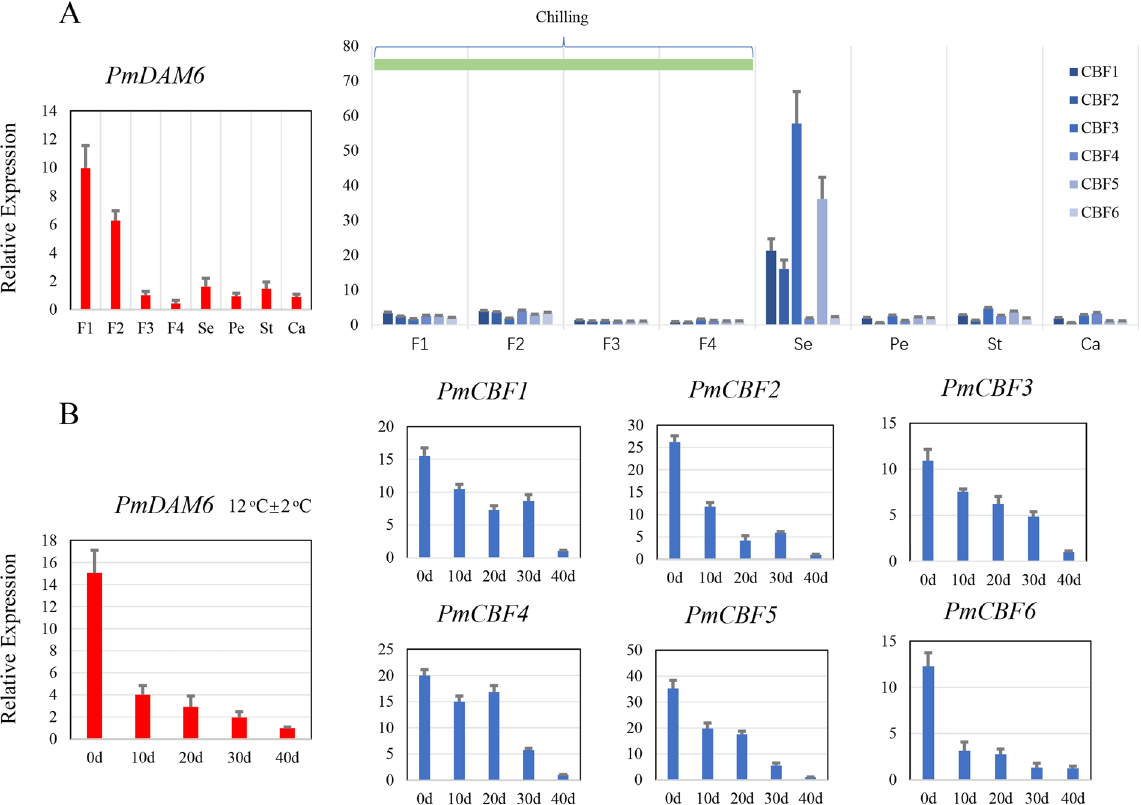
Figure 4. Expression patterns of PmDAM6 and PmCBFs in bloom process and different flower structures. ( A ) The flower blooming process was manually divided into four stages according to the size of buds. F1:Small flower bud;F2:Big flower bud;F3:First blooming;F4:Full blooming. The mature flower was disassembled into four parts. Se:Sepal;Pe:Petal;St:Stamen;Ca:Carpel. ( B ) The expression levels of PmDAM6 and PmCBFs in the simulated dormancy release test, the samples were collected from the second stage (blue arrow in Fig. 3A). (Warm: higher than 20 °C, Chilling: lower than 20 °C, Freezing: lower than 0